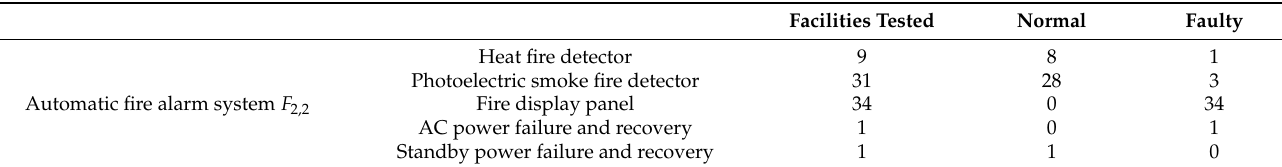
Table 8. Scoring details of factor F 2,2 in the maintenance